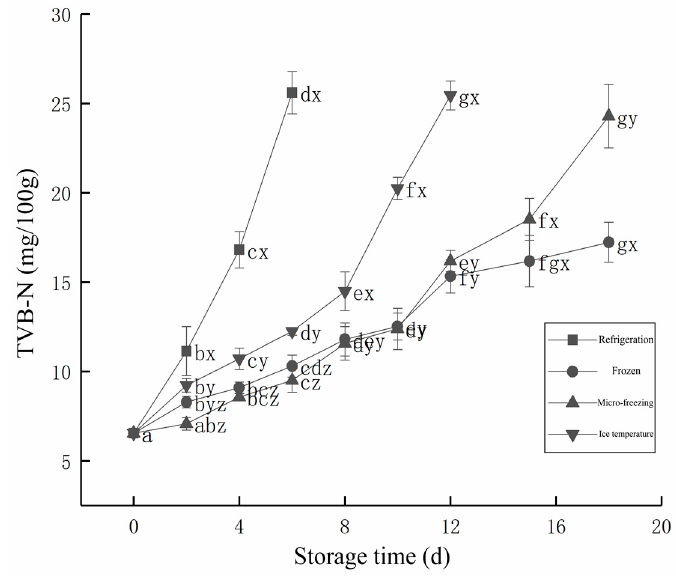
Figure 4. Changes in the TVB-N value of beef in different low-temperature storage methods during storage. d, day.